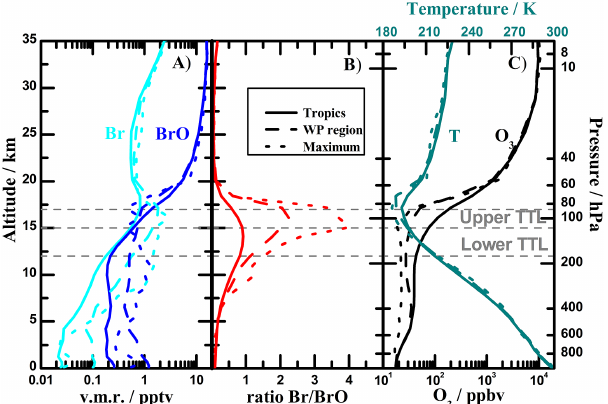
Figure 4. Vertical noontime profiles of Br and BrO vmr (a) , the Br / BrO ratio (b) , and T and O 3 (c) in the tropics. Vertical profiles have been averaged over different regions and time periods: (solid) annual tropical averages (20 ◦ N–20 ◦ S); (dashed) WP region during February; (dotted) at the midpoint of a strong convective cell within the WP during a 3-day period in